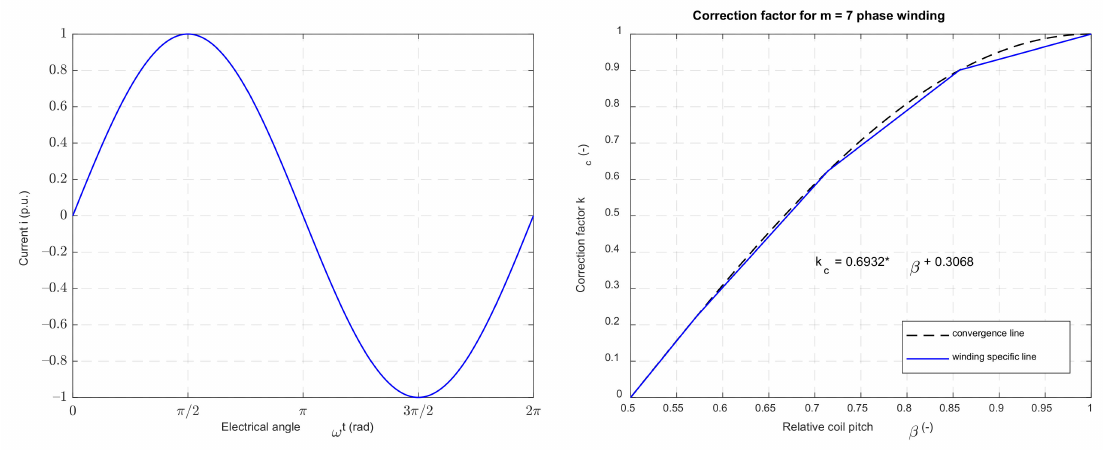
Figure 6. Waveform of harmonic current and the correction factor, k c , of seven-phase winding.